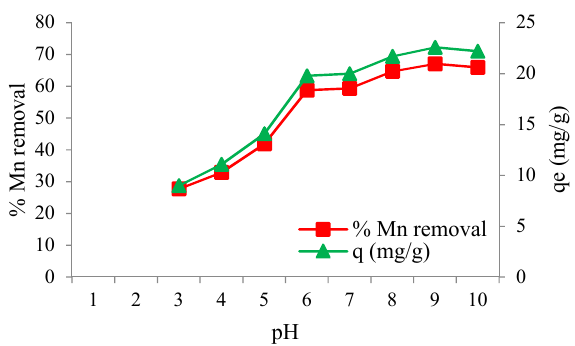
Fig. 5. Effect of pH on Mn 2+ removal by impregnated active carbon (C 0 =120 ppm, T=25 ºC, mixing rate=100 rpm, active carbon=4 g/l)